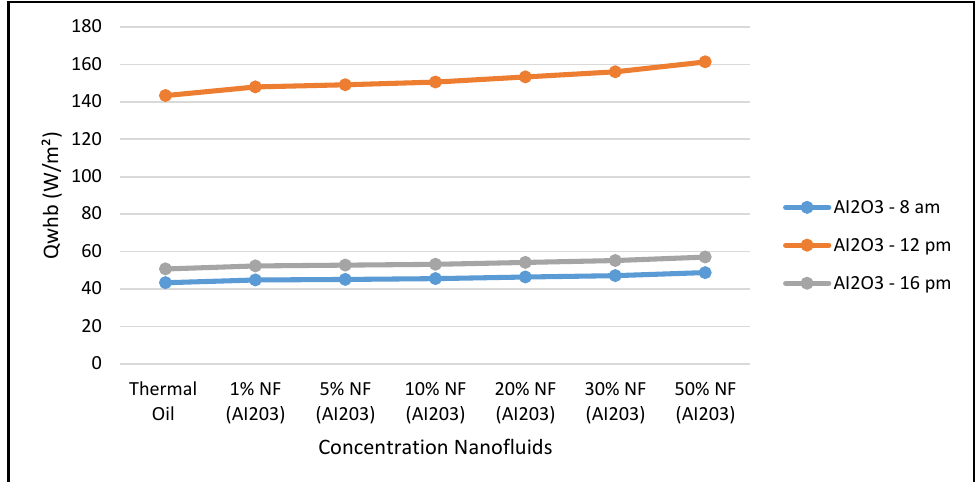
Appl. Syst. Innov. 2019 , 2 , x FOR PEER REVIEW Figure 14. Thermal energy supplied to waste heat boiler storage at different concentrations of Al 2 O 3. Figure 14. Thermal energy supplied to waste heat boiler storage at di